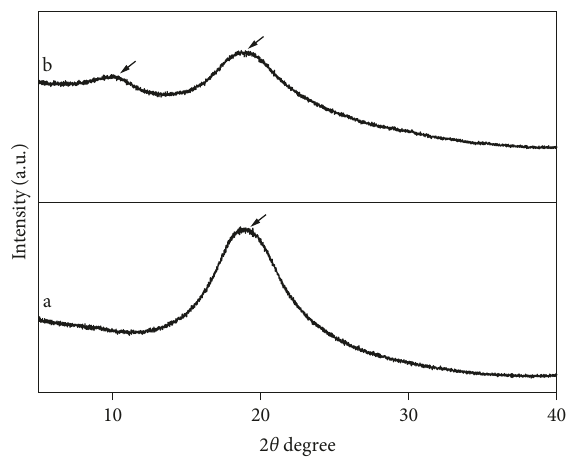
Figure 4: XRD spectra of pure PVA sponge (a) and the silylated PVA sponge (b).